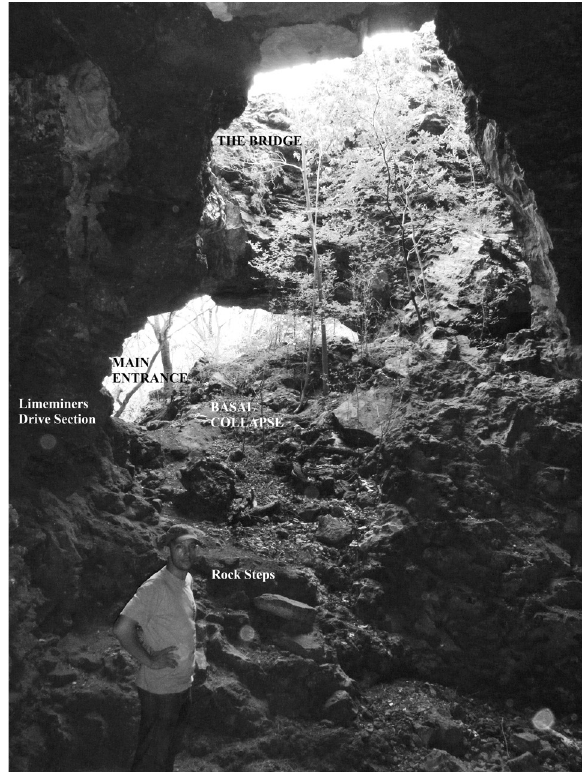
Major features of the Eastern Deposits of the Haasgat mine and its palaeocave deposits looking east from the entrance to Tetley’s Hall (perspective shown in plan of Figure 4).